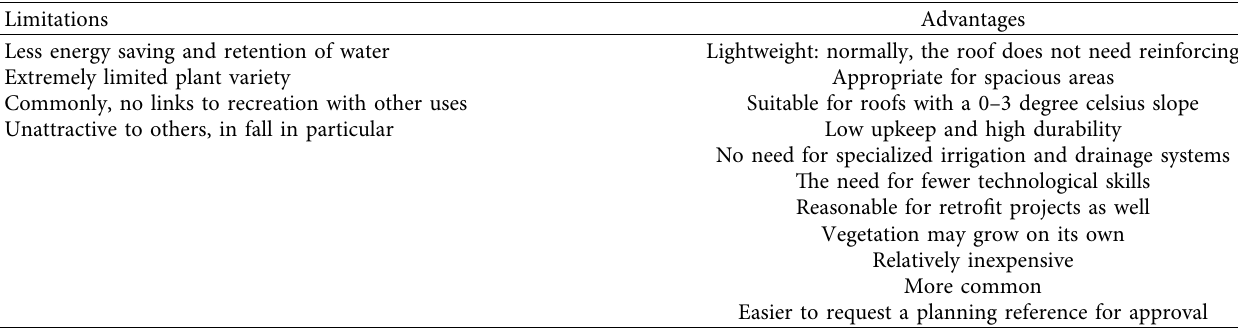
Table 4: Advantages and limitations of the extensive